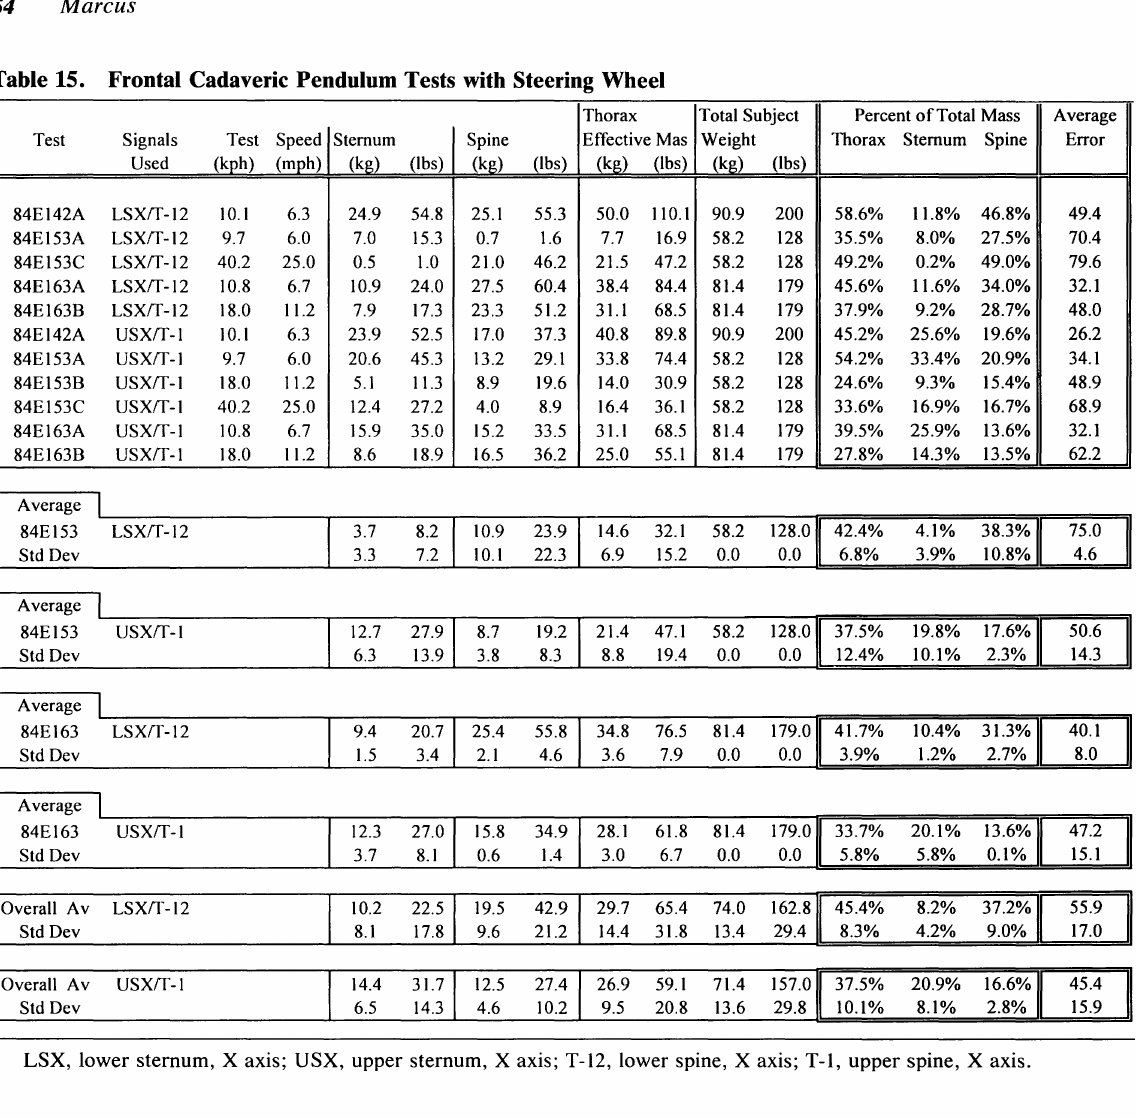
Table 15. Frontal Cadaveric Pendulum Tests with Steering